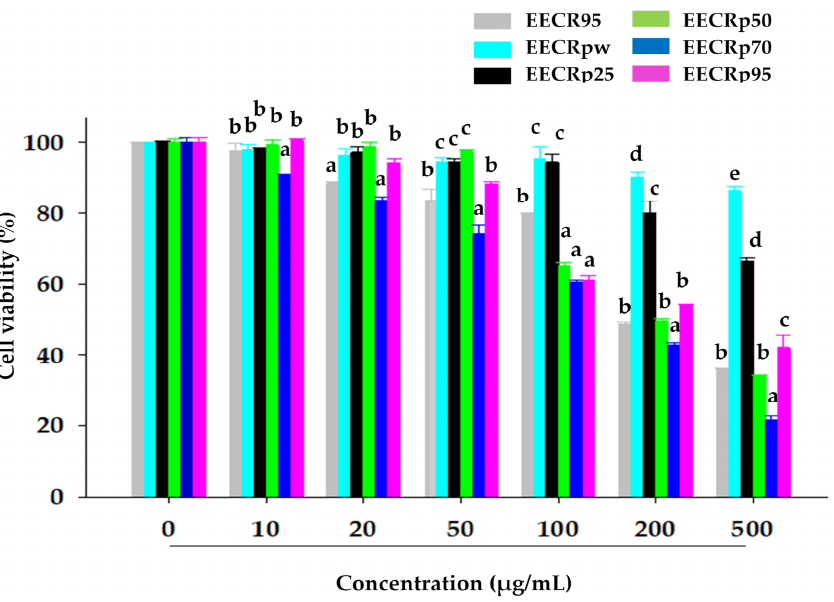
Figure 3. Effects of EECR95 and its sub-fractions on cell viability of SCC25 cells during a 24 h incubation. Cells were treated with (0–500 µg/mL) sub-fraction for 24 h incubation. After treatment, cell viability was measured by MTT assay. EECR95: 95% ethanol of C. cajan roots, EECRpw: sub-fraction of EECR95 in water, EECRp25–p95: 25–95% ethanol sub-fraction of EECR95. Values (mean ± SD, n = 3) that do not share a common letter are significantly different ( p < 0.05).